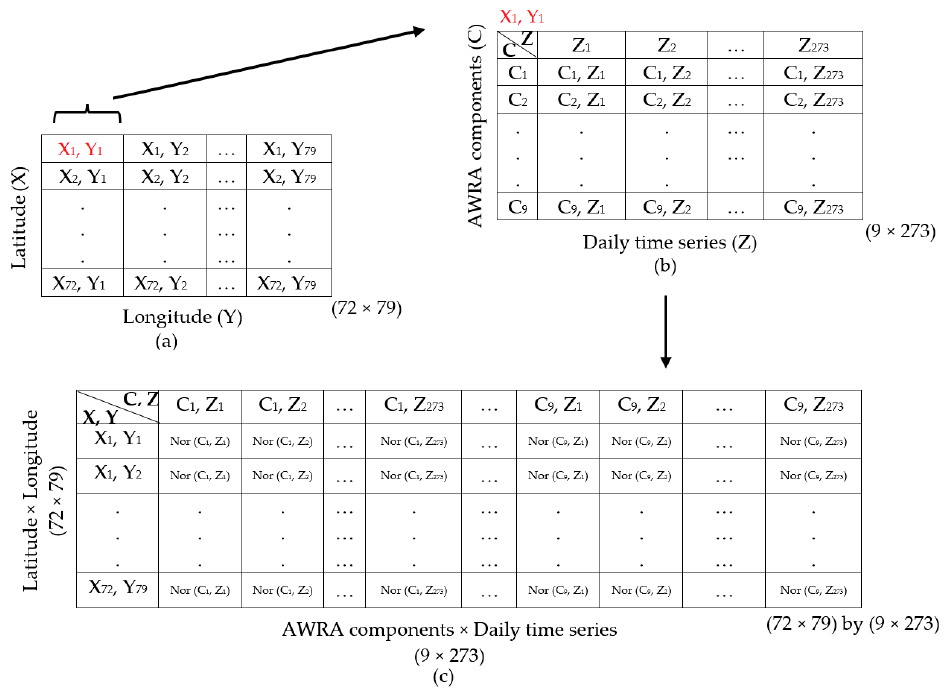
Figure 2. ( a ) Three-dimensional arrays of hydrological variables at the spatial grid scale of ( − 43.71 < latitude < − 40.14) and (144.49 < longitude < 149.41) of size (72 × 79), ( b ) a spatial grid e.g., (X 1 , Y 1 ) consists of (9 × 273) observations and ( c ) three-dimensional arrays are normalized (Nor) and append to each other to form a single three-dimensional array of size (72 × 79) by (9 ×